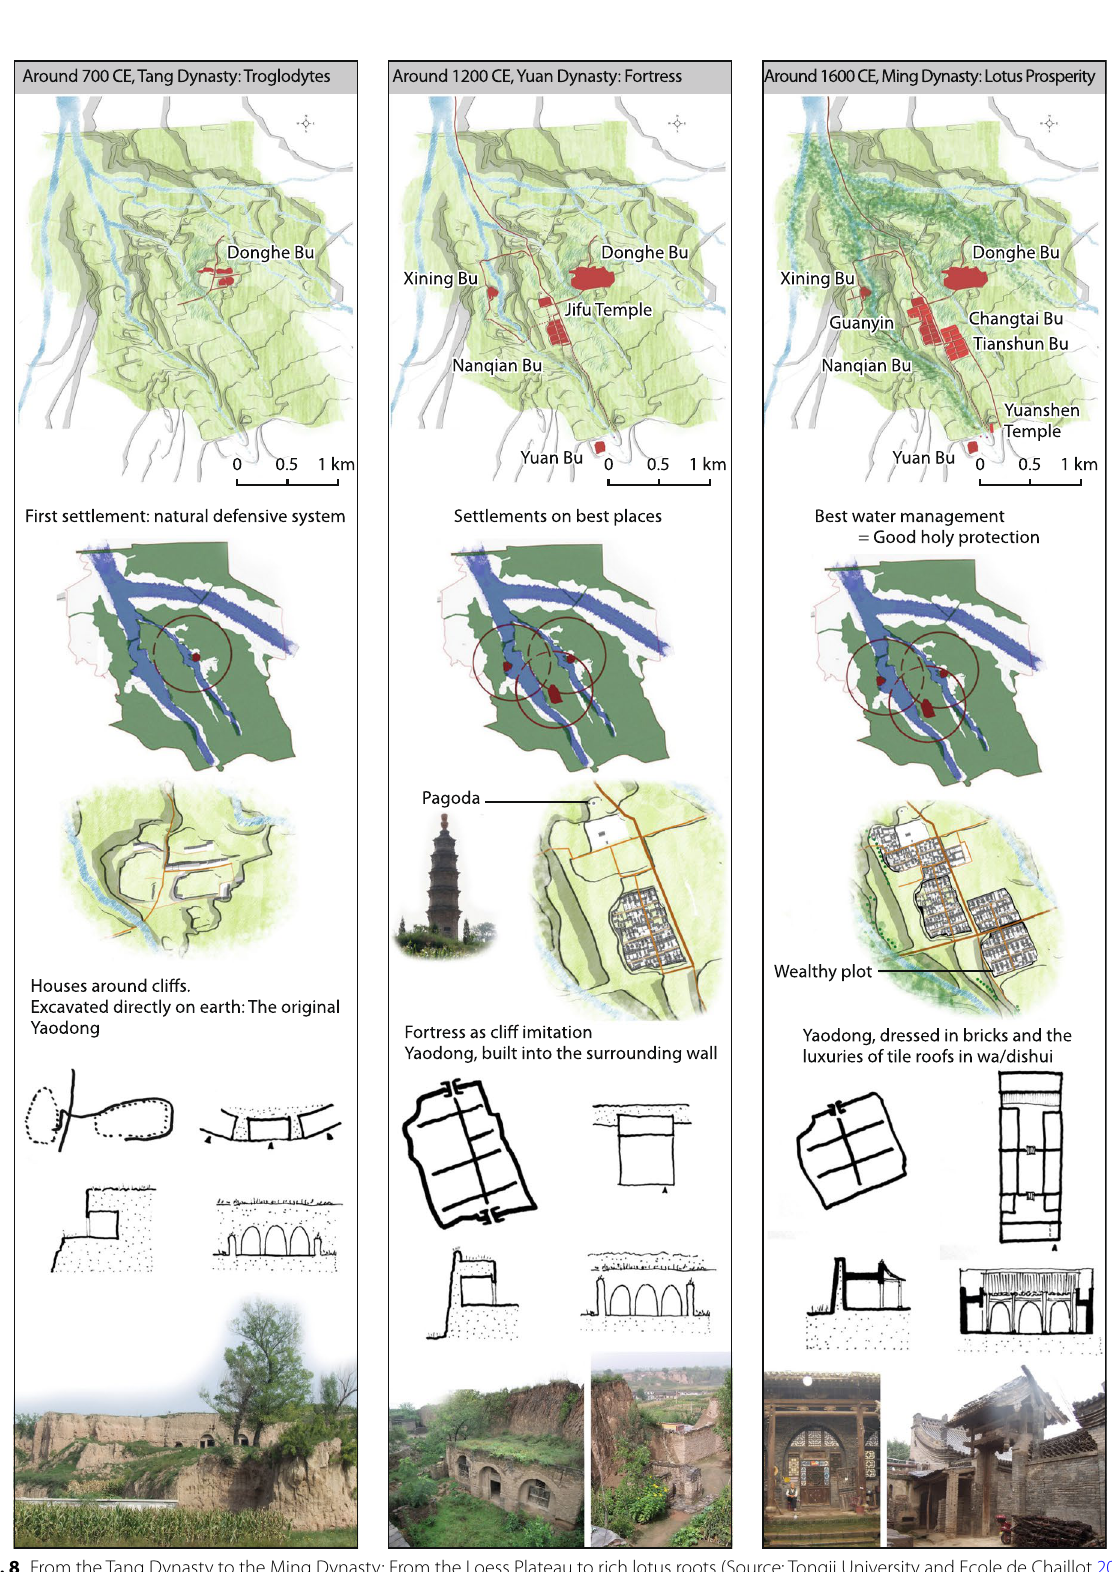
Fig. 8 From the Tang Dynasty to the Ming Dynasty: From the Loess Plateau to rich lotus roots (Source: Tongji University and Ecole de Chaillot